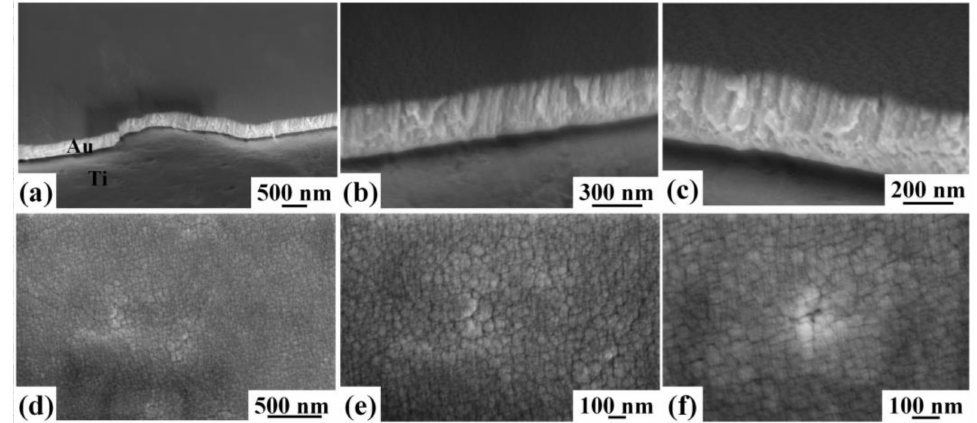
Figure 3. Cross-section (( a – c ), with magnification increase from ( a ) to ( c )) and plan-view (( d – f ), with magnification increase from ( d ) to ( f )) SEM images of the thicker (350 nm-thick) Au film deposited at θ = 0 ◦ on Ti (sample